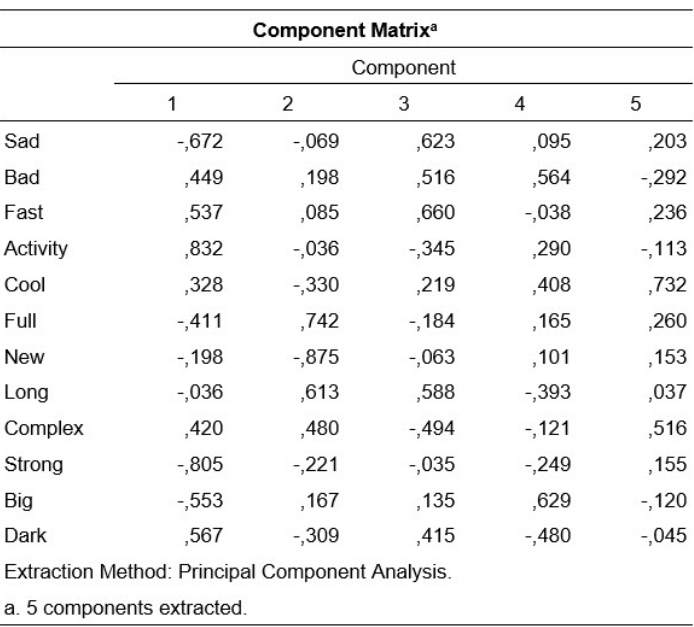
Component matrix for Group